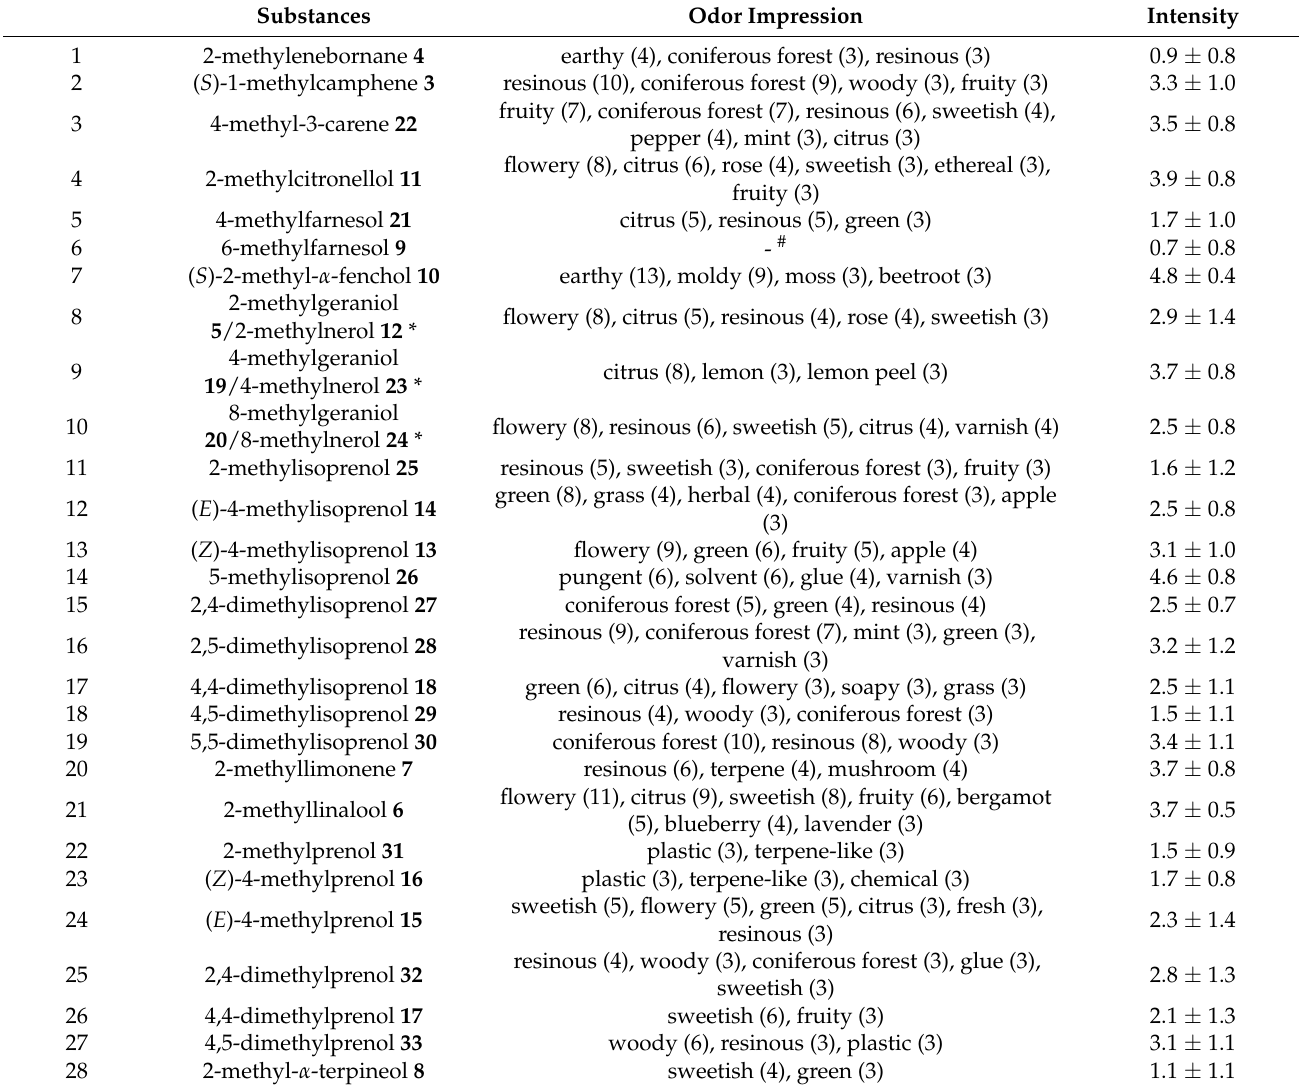
Table 2. Odor descriptions of pure methylated hemi-, mono-, and sesquiterpenes, which were given by at least three participants, with the number of mentions in parentheses ( n =